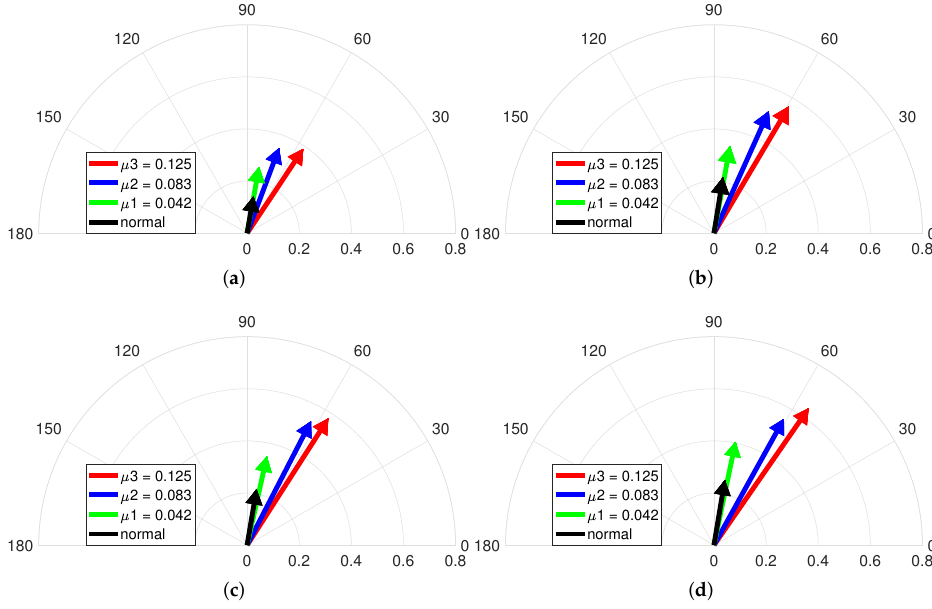
Figure 12. Vector diagram at ( a ) 2000, ( b ) 3000, ( c ) 4000, and ( d ) 4500 rpm and 4.5 Nm with µ .